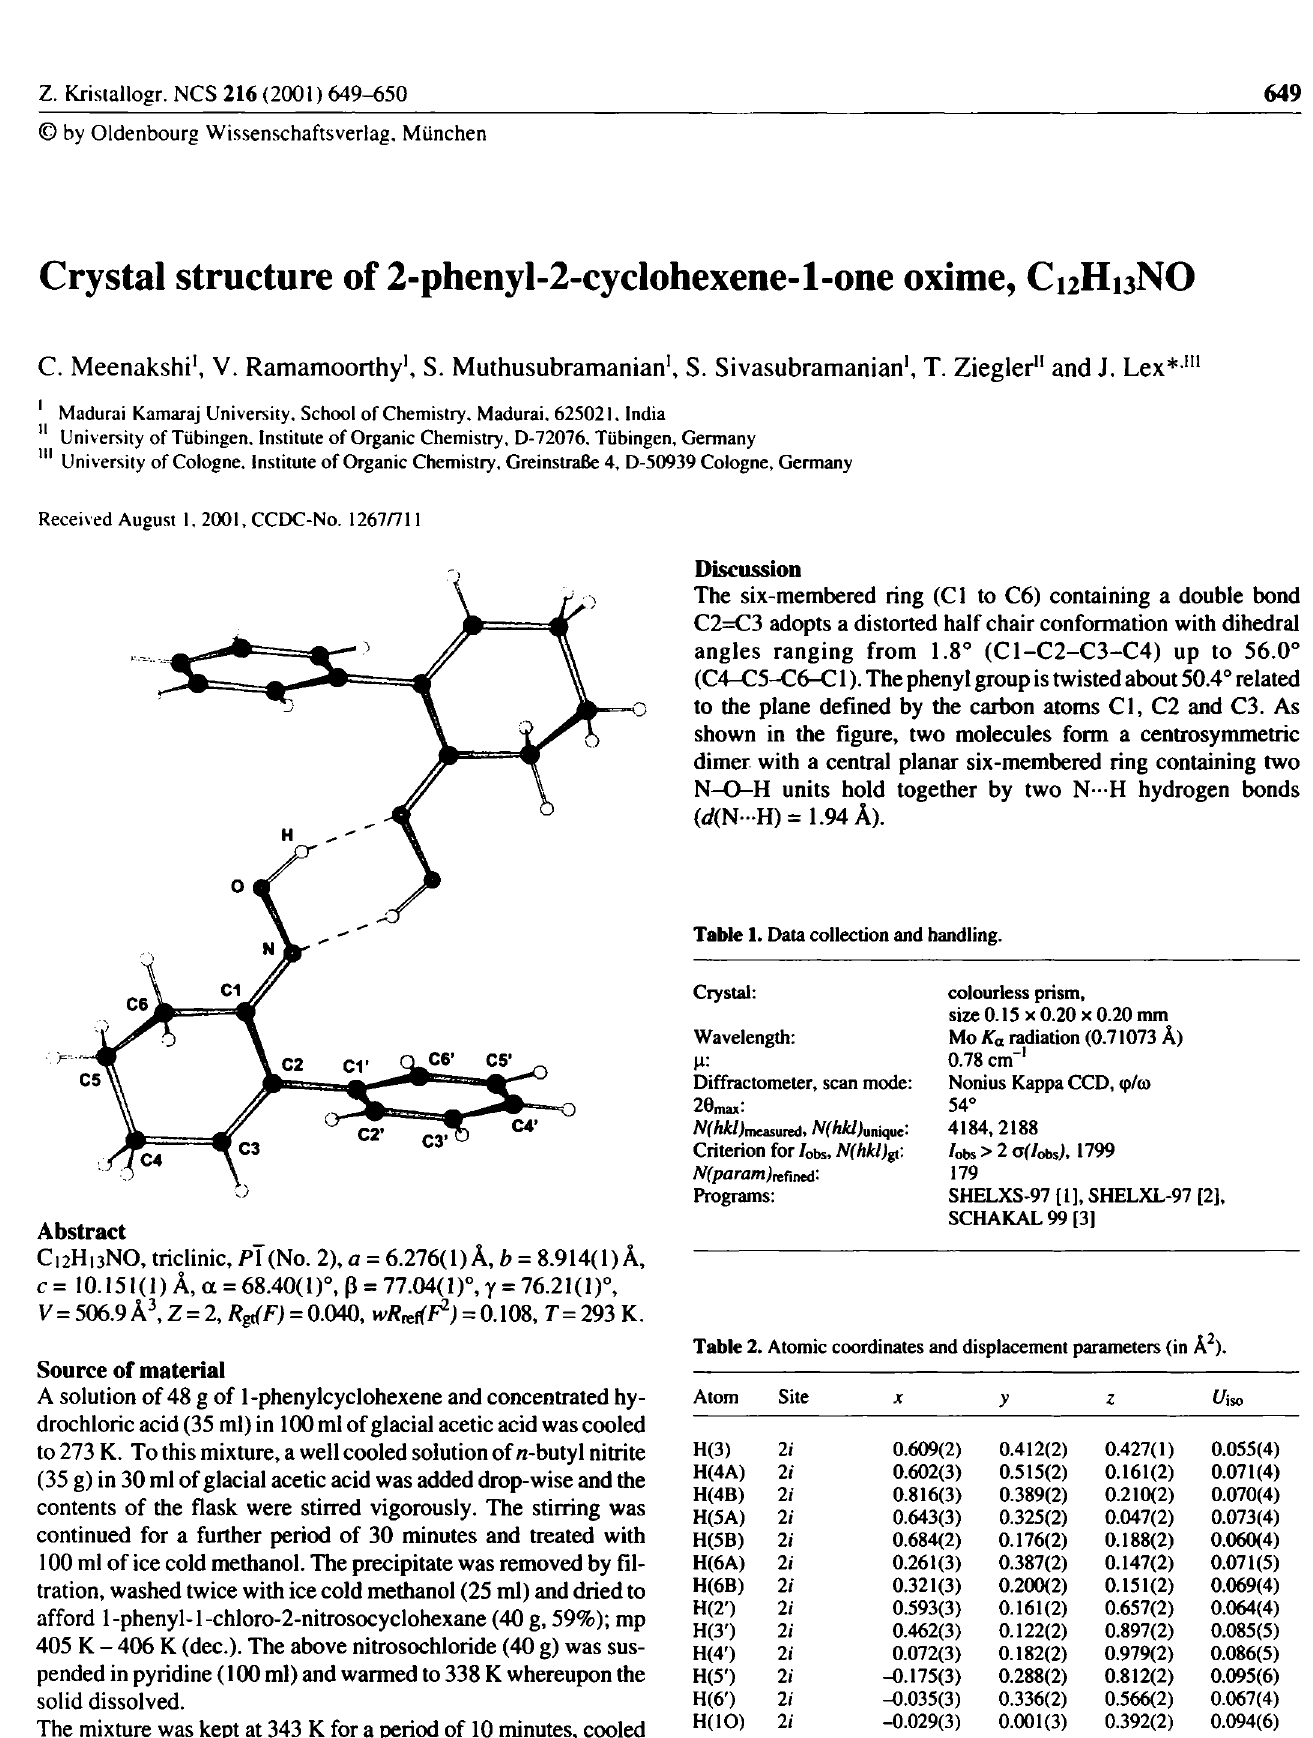
Table 2. Atomic coordinates and displacement parameters (in Ä 2